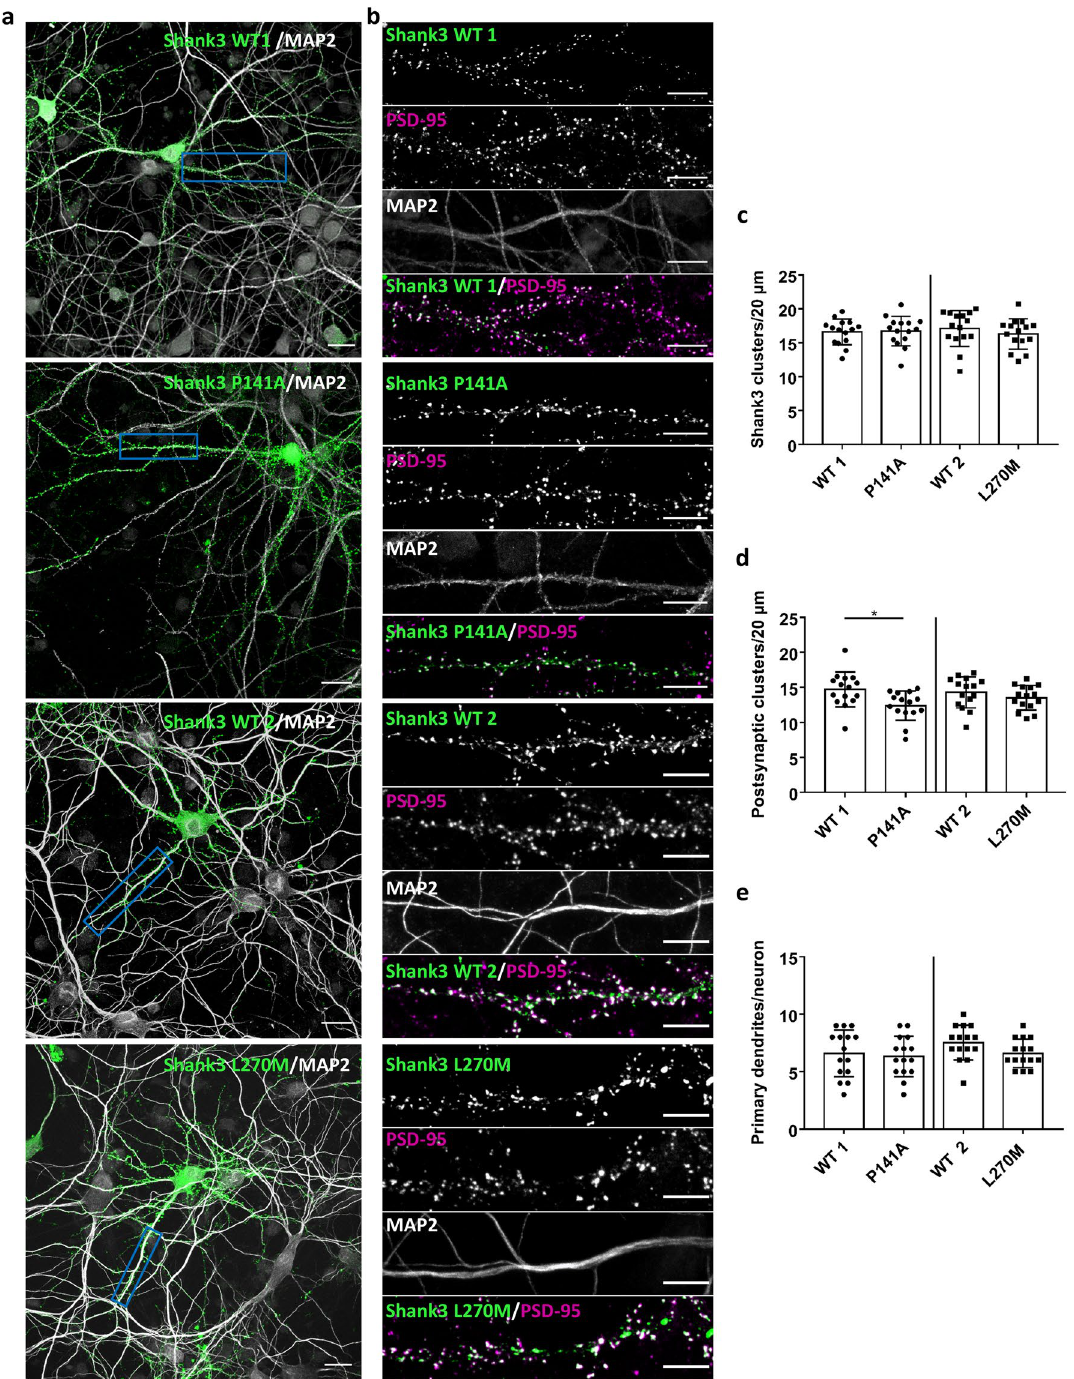
Figure 10. Primary hippocampal neurons expressing GFP-Shank3 (WT or P141A, L270M mutants) were fixed and stained for the postsynaptic marker PSD-95 and the dendritic marker MAP2 (gray). The expressed Shank3 variants were detected using the GFP fluorescence. ( a ) Overview images of neurons (scale bar 20 μm). ( b ) Boxed dendritic areas were magnified (scale bar 10 μm). GFP-Shank3 colocalises extensively with PSD-95 in presumably postsynaptic clusters, which are found in a small distance from the (MAP2-positive) main dendrite. ( c ) Quantitative evaluation of the total number of Shank3 clusters per 20 μm dendrite. ns: non-significant; analysis of 45 dendrites of n = 15 neurons from three independent experiments; t-Test. ( d ) Quantitative evaluation of the number of postsynaptic Shank3 clusters (Shank3 clusters colocalising with PSD-95) per 20 µm dendrite. *Significantly different from WT, p < 0.05; analysis of 45 dendrites of n = 15 neurons from three independent experiments; t-Test. ( e ) Quantitative evaluation of the number of primary dendrites per neuron. ns: non-significant; analysis of n = 15 neurons from three independent experiments;